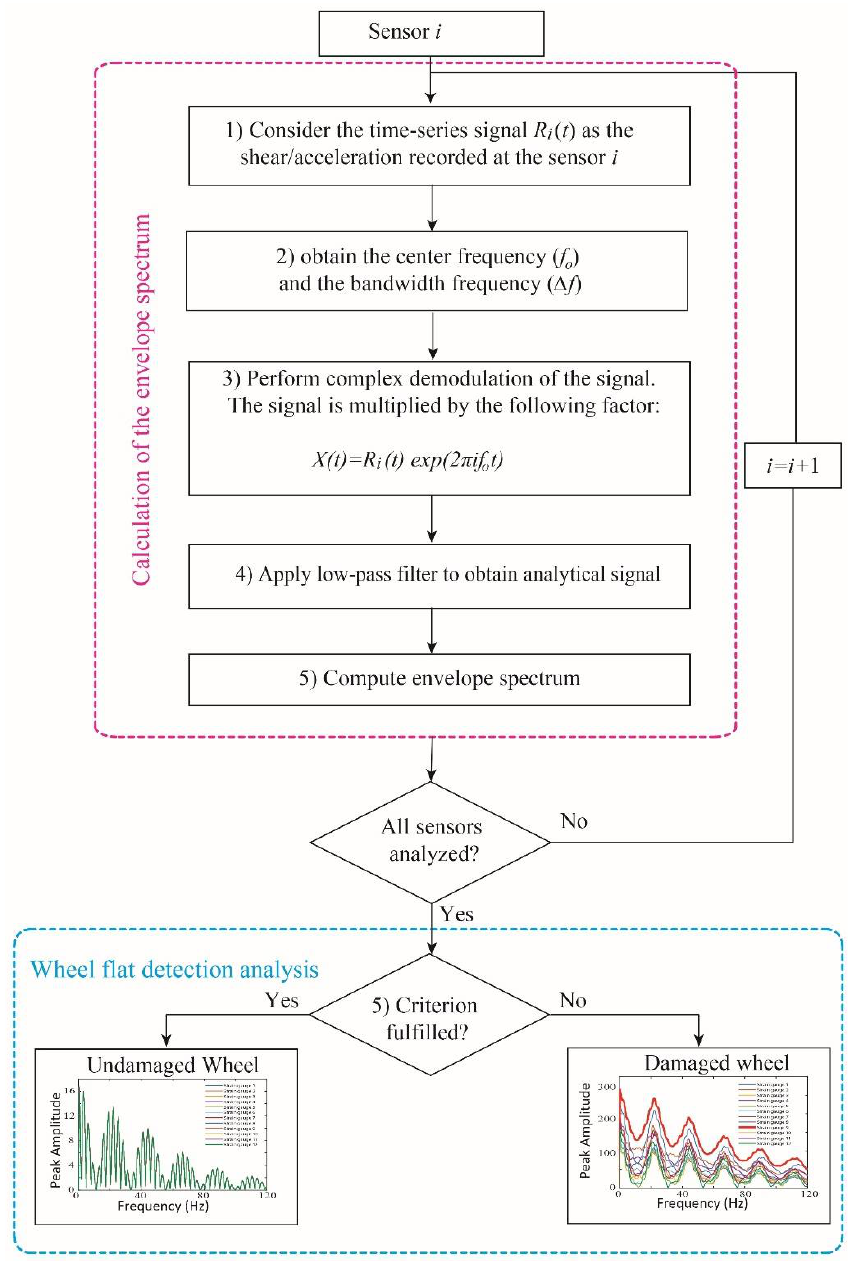
Figure 6. The methodology to identify a defective wheel.